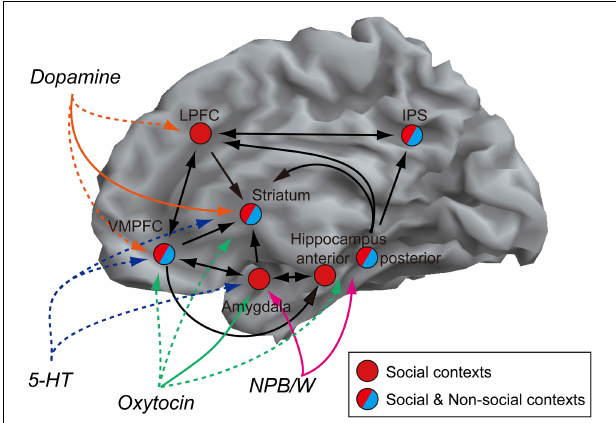
FIGURE 2 | Network model of social dominance. Regions that have been reported to be involved in the perception of social dominance are shown. The black lines and arrows indicate possible direct connections between regions based on the anatomical studies (Clower et al., 2001; Freese and Amaral, 2009; Haber and Knutson, 2010; Yeterian et al., 2012). In terms of transmitters, the colored solid lines indicate target regions with scientific reports for hierarchy (Grant et al., 1998; Morgan et al., 2002; Brezillon et al., 2003; Timmer et al., 2011). The colored broken lines indicate possible regions that these transmitters could have effects (Passchier et al., 2000; Landgraf and Neumann, 2004; Hurd and Hall, 2005), but no scientific report in terms of social dominance and